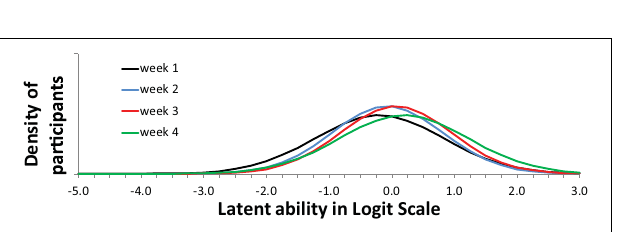
FIGURE 7 | Item profiles for four topic/question sets. On the x-axis is the latent ability/advancedness scale, as explained earlier.